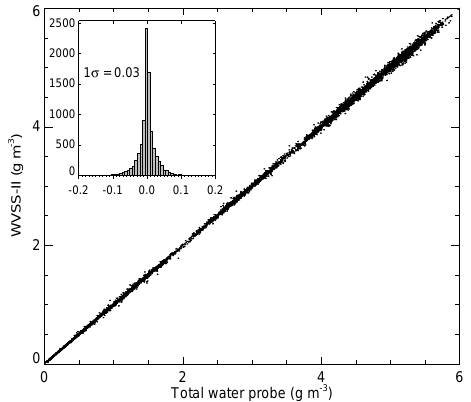
Figure B1. Water vapour content from the total water probe and flush-mounted WVSS-II in clear-air conditions during flight B667. The dashed line is the 1 : 1 line. The inset panel shows a histogram of the difference between the total water probe and WVSS-II mea-